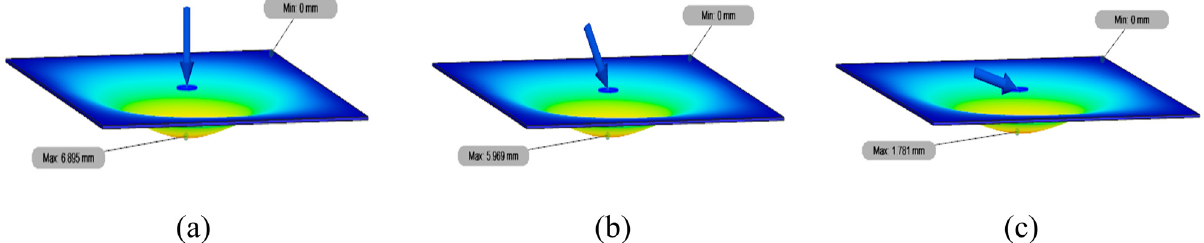
Figure 17: The displacement contour of unsti ff ened medium - carbon steel plates subjected to a centred structural load ( Model 7 ) at the loading angles of ( a ) 0°, ( b ) 30°, and ( c )